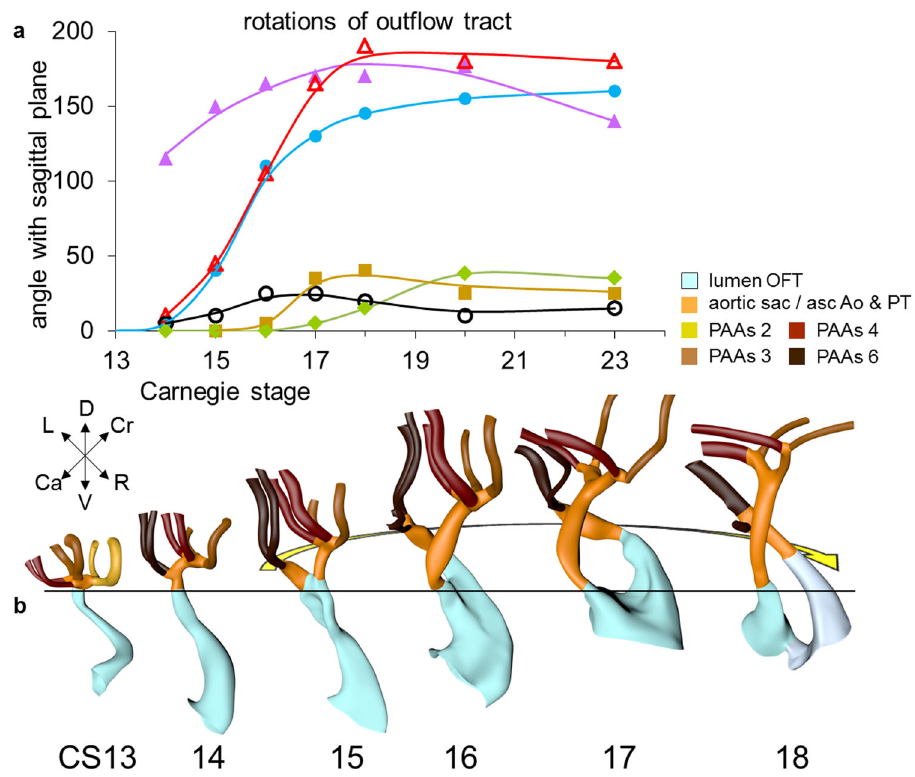
Fig. 9 Changes in the course of the (sub-)aortic and (sub-)pulmonary channels. The graph ( a ) shows the changes in the degree of spiraling of the bloodstreams in time and place. The reference plane is sagittal and each dot represents a single embryo. Axial changes in the position of the components of the out fl ow tract were measured as described in Supplemental Fig. 18. The line connecting the center of the ridges at their proximal ends is shown in purple solid triangular symbols, with the comparable line at their distal ends shown in red open triangular symbols. The blue solid circular and black open circular symbols identify the line connecting the centers of the ori fi ces of the ascending aorta and pulmonary trunk at their proximal and distal ends, respectively, with the distal end of the ascending aorta measured at the pericardial re fl ection. The brown square symbols show the movement of the distal endocardial ridges relative to the distal ori fi ces of the subaortic and subpulmonary channels. The green diamond-shaped symbols show the asymmetric development of the horns of the aortic trunk measured as the angle of the lines connecting their junctions with the pharyngeal arch arteries. Comparison of the red (open triangular) and purple (solid triangular) symbols shows that, by CS17, the endocardial ridges have lost the initial spiraling arrangement identi fi able at CS14. The change in orientation of the myocardialized proximal ridges between CS20 and CS23, as they transform into the subpulmonary infundibulum, accounts for the decline in the purple symbols (see Fig. 10 for morphological details). The compensatory spiraling of the intrapericardial course of the arterial trunks, as shown by the blue symbols, re fl ects the oblique ventral extension of the aortopulmonary septum, with the black symbols showing that the change in position of the arterial trunks at their connection with the pharyngeal arch arteries contributes to a much lesser extent. The images in panel b (same viewing angle as Fig. 7h – n) are aligned on the location of the developing aortic valve (black line). The horizontal yellow arrow shows the changing position of the (sub-)aortic and (sub-)pulmonary channels in the middle and distal portions of the out fl ow tract. These channels separate between CS14 and CS15 in the distal out fl ow tract, during CS16 and CS17 in the middle out fl ow tract, and between CS18 and CS20 in the proximal out fl ow tract. All images are also available as preset views in the corresponding